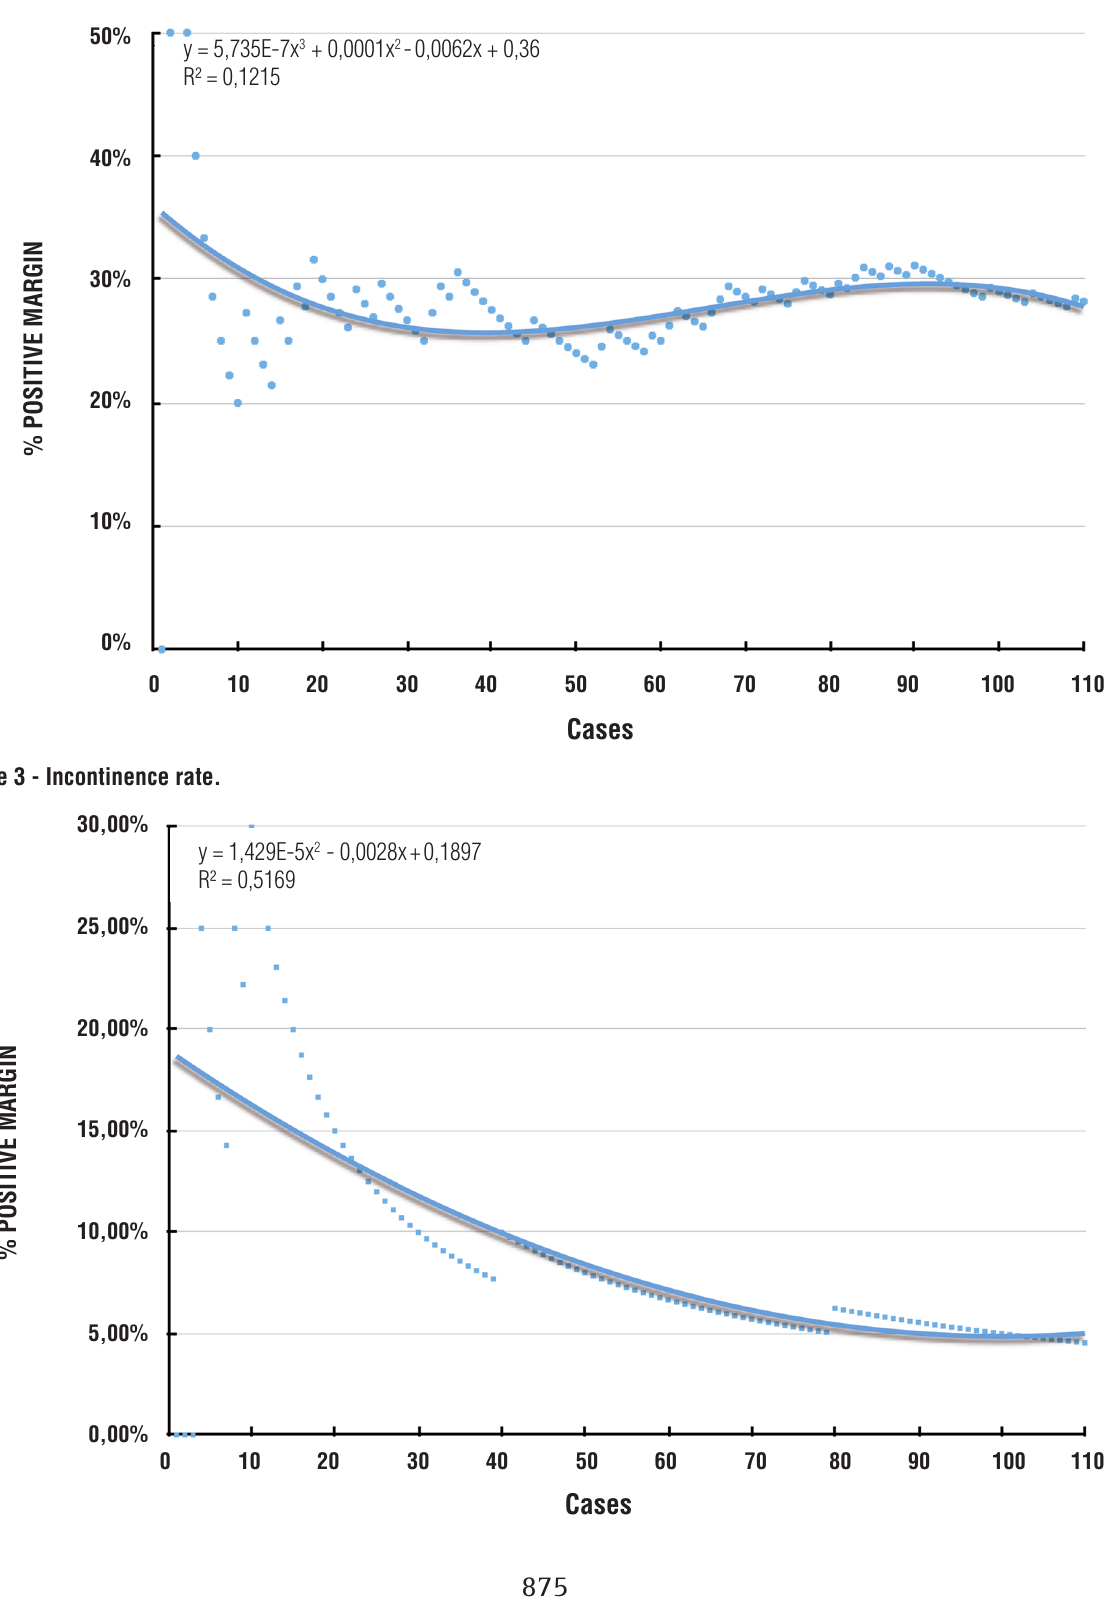
Figure 2 - Positive surgical margin rate.